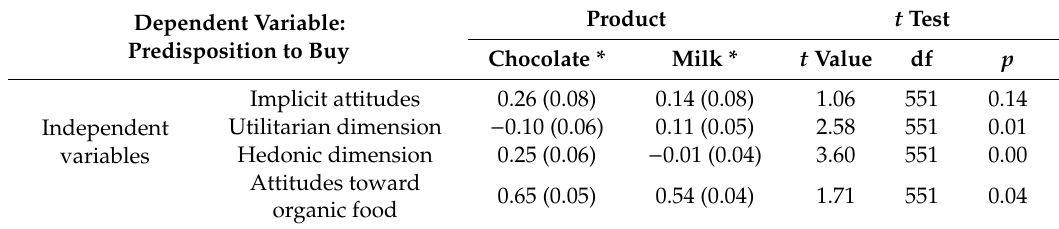
Table 6. Equivalence of the construct coe ffi